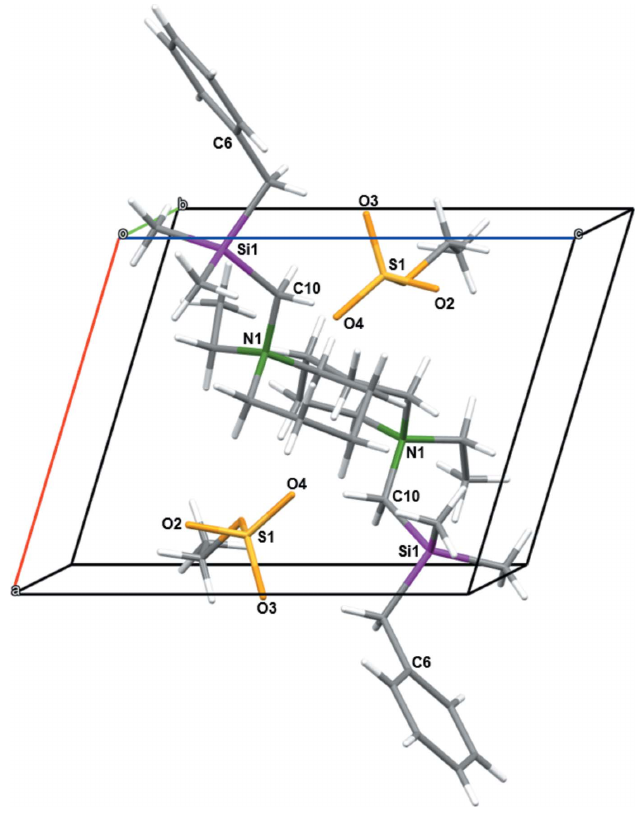
Figure 3 A view along the b -axis direction of the crystal packing of compound 1